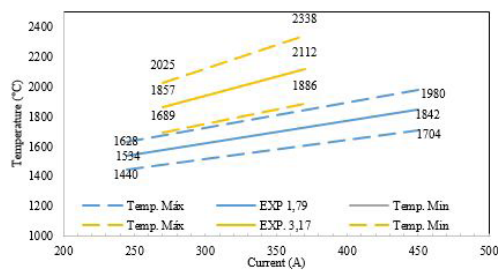
Figure 9. Weld pool temperature versus Pulse